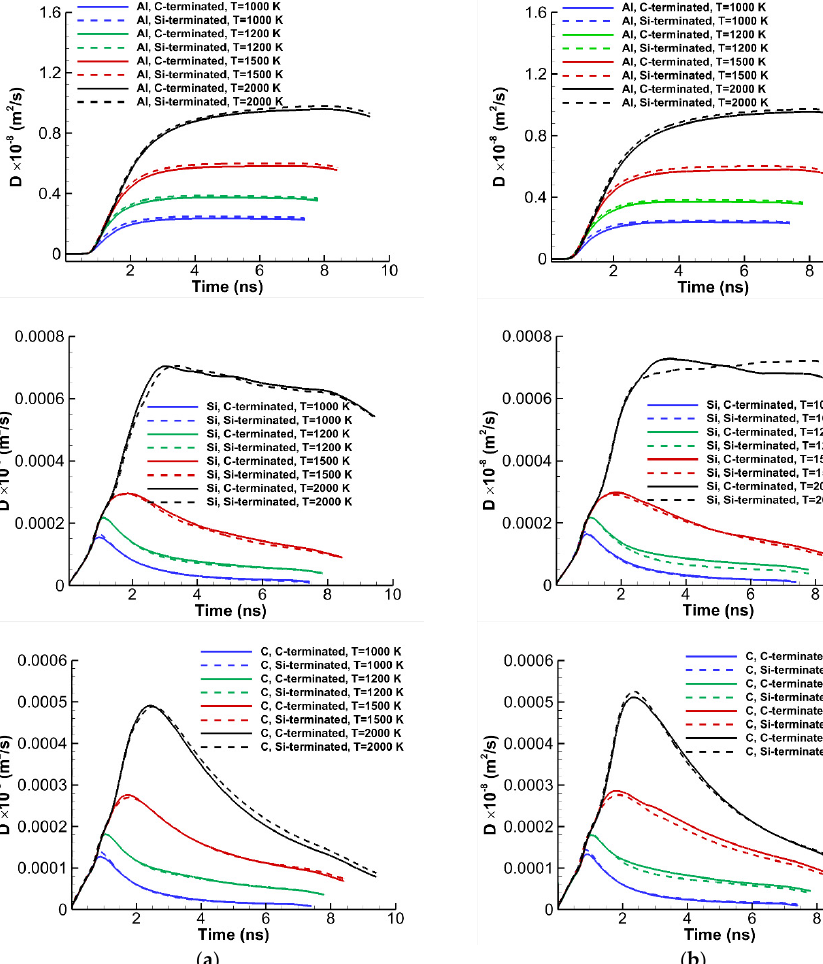
Figure 7. Time histories of the self-diffusion coefficient at different temperatures for different atoms of the ternary systems. The C − and Si − terminated ( a ) 6H − SiC/Al interface and ( b ) 3C − SiC/Al interface.